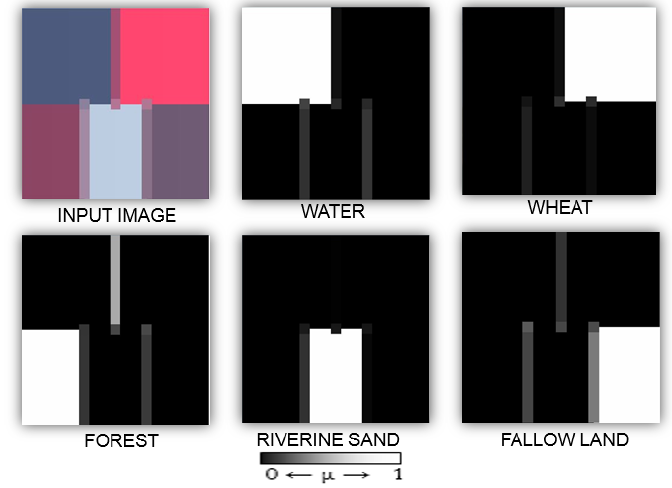
Figure 5. The result of simulated image using Cosine measure with m* equals to 2.7.